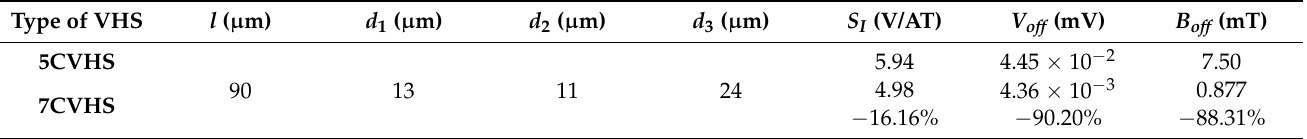
Table 2. Size and performance comparison of the model in Figure 2.